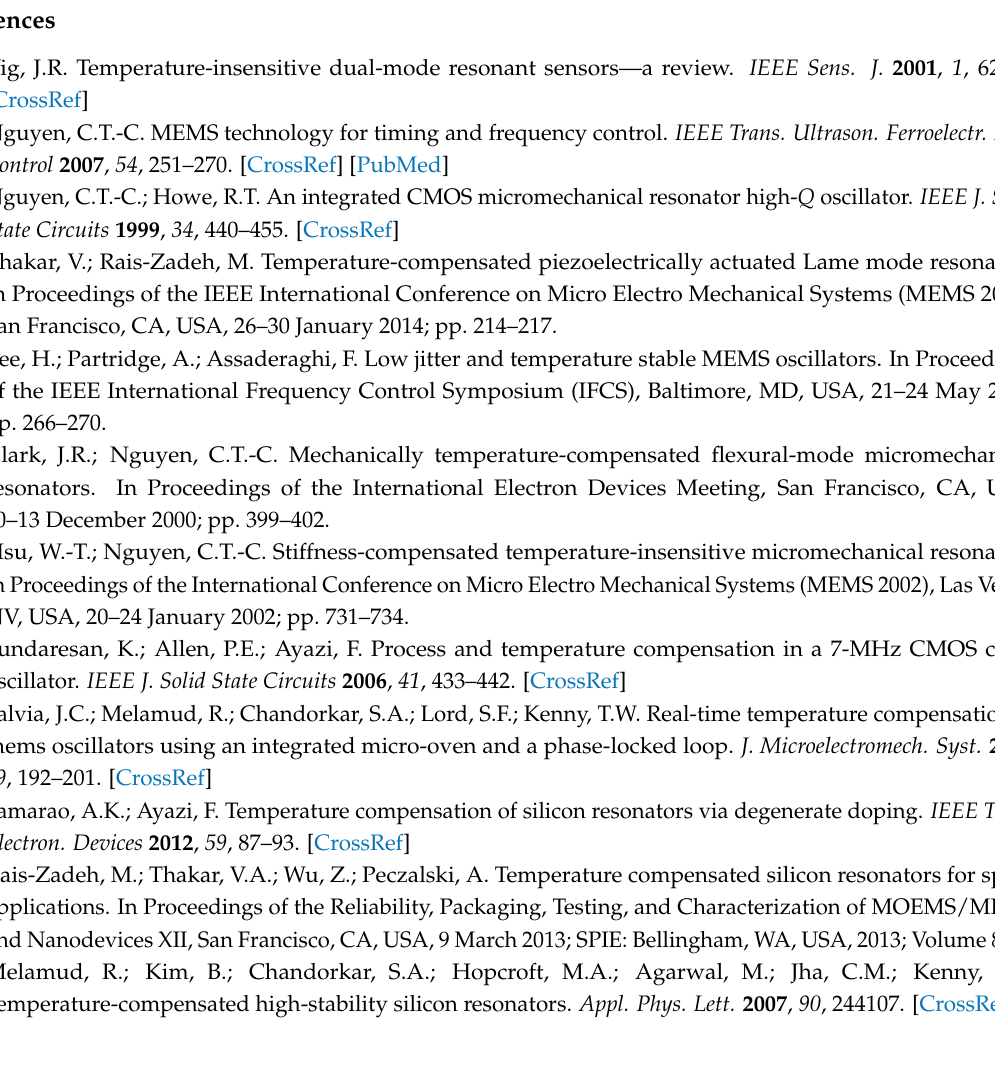
s1, Figure S1. Schematic of the optical measurement system used for characterizing the open-loop resonance response and TC f of the single-crystal SOI MEMS comb-drive resonator. Figure S2. Power spectral density (PSD) and stability estimation: (a) PSD of uncompensated and compensated oscillation frequency; (b) PSD of ambient temperature fluctuations; (c) Allan deviation of uncompensated and compensated oscillation frequency; and (d) Allan deviation of the temperature data shown in (b). Figure S3. Oscillation frequency traces versus time, measured at five different temperature values set and controlled by the sample heating and cooling modules, for oscillators (a) without and (b) with temperature compensation, respectively. Inset plot in (b) shows zoomed-in view of the red box in (b). Table S1. Fractional frequency shift with and without temperature